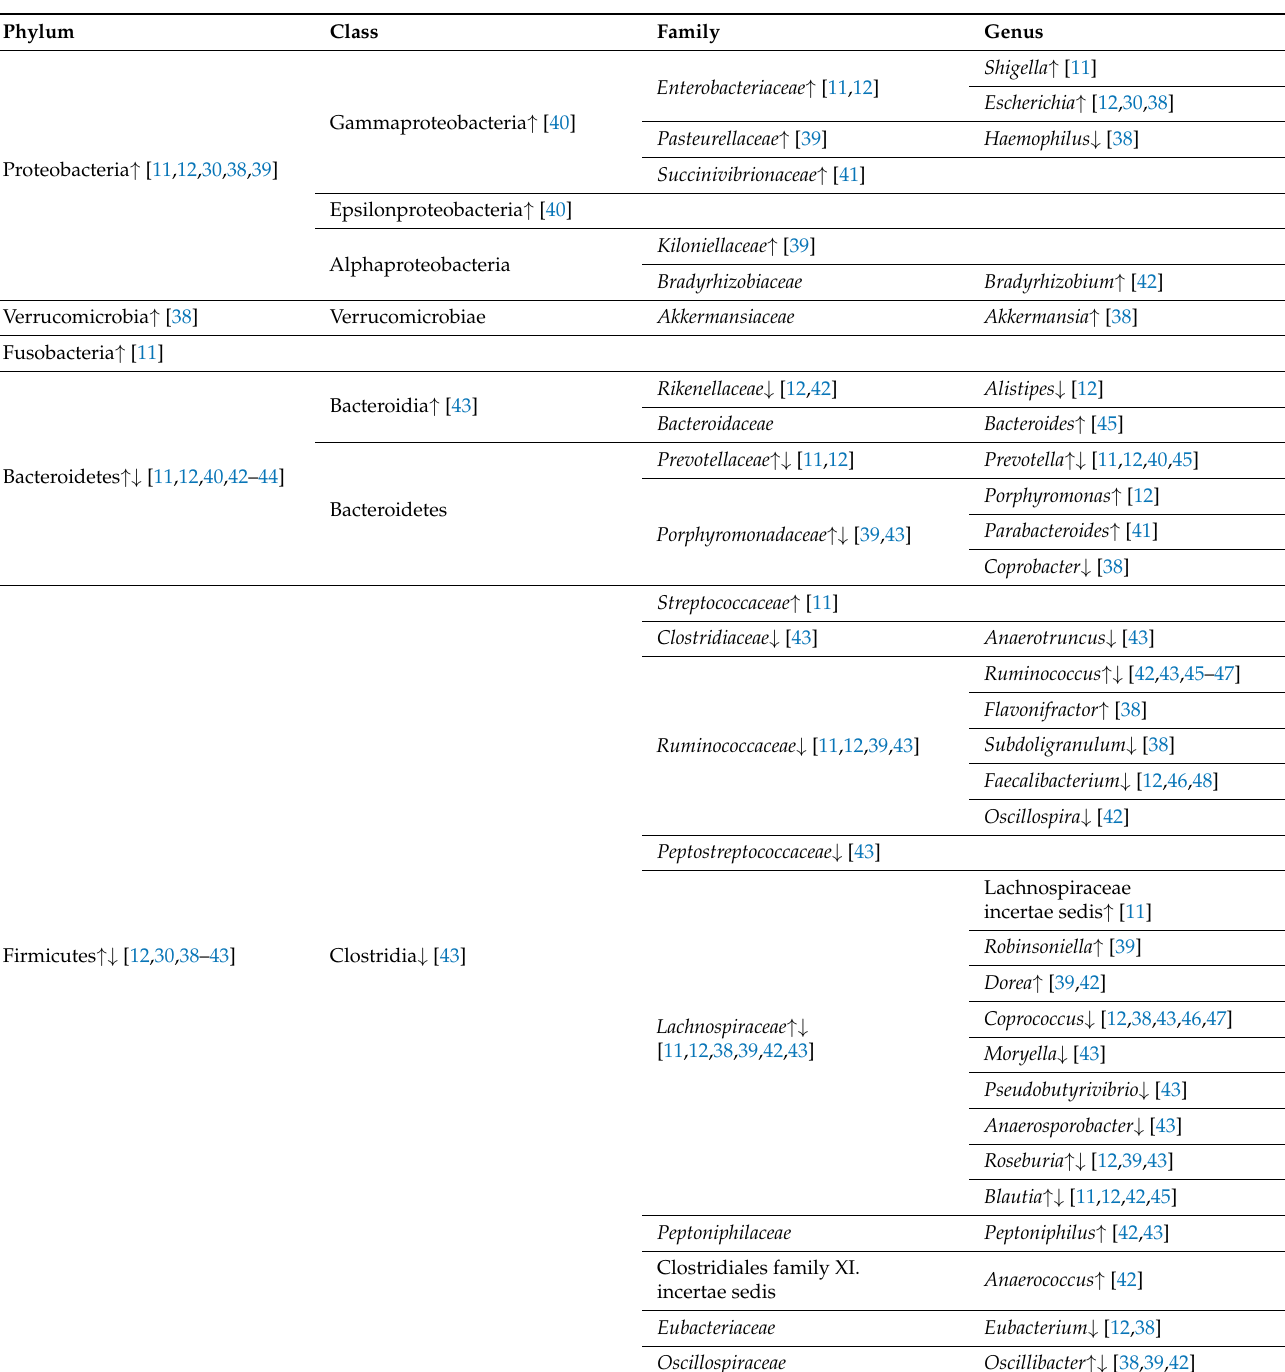
Table 1. NAFLD-associated gut microbiota